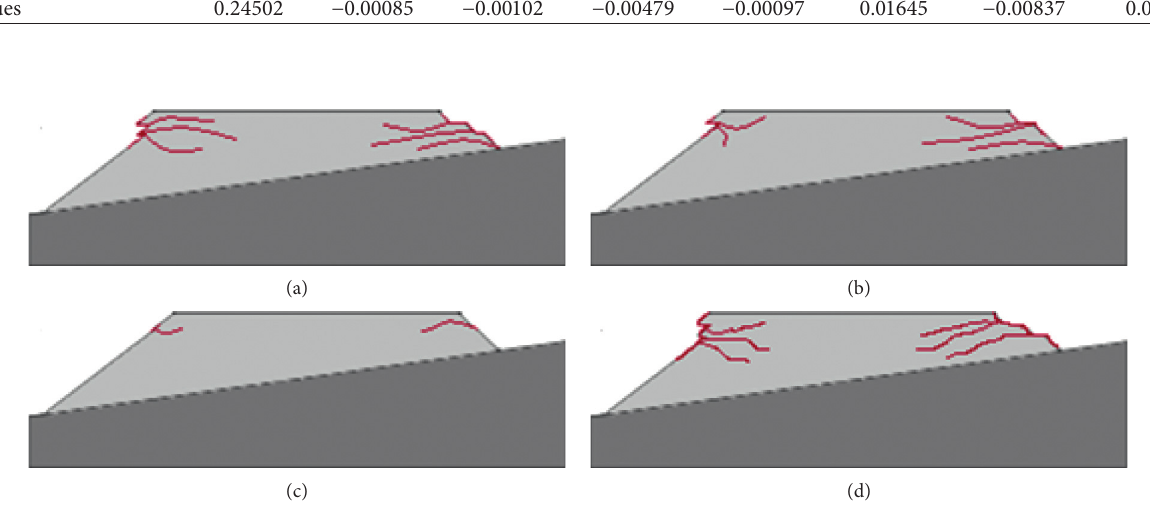
Figure 6: Embankment seismic damages of R � 10km. (a) Seismic damages of the 11th combination (F1 � F2 � F3 � 0, PGA � 1.2g, and ε max � 1.8433). (b) Seismic damages of the 14th combination (F1 � F2 � F3 � 0, PGA � 0.7g, and ε max � 0.6874). (c) Seismic damages of the 18th combination (F1 � F2 � F3 � 0, PGA � 1.2 g, and ε max � 0.2687). (d) Seismic damages of the 27th combination (F1 � F2 � F3 � 0, PGA � 1.197g, and ε max � 1.8075).